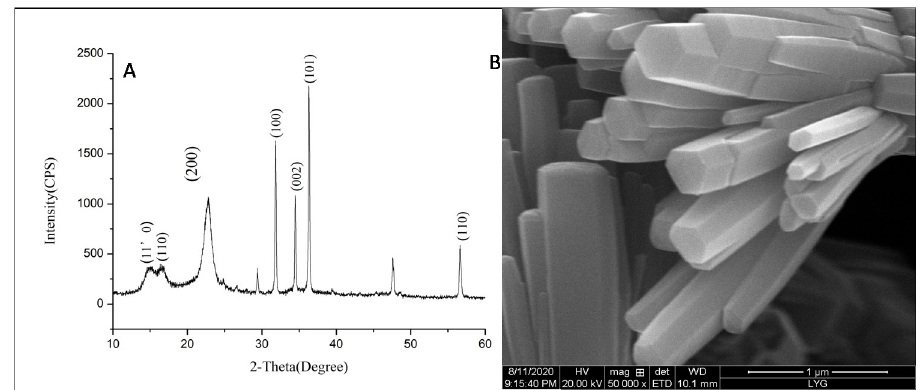
Fig 4. Characterization of prepared nano-ZnO. (A) XRD analysis of nano-ZnO. (B) The shape of nano-ZnO acquired by scanning electron microscope.